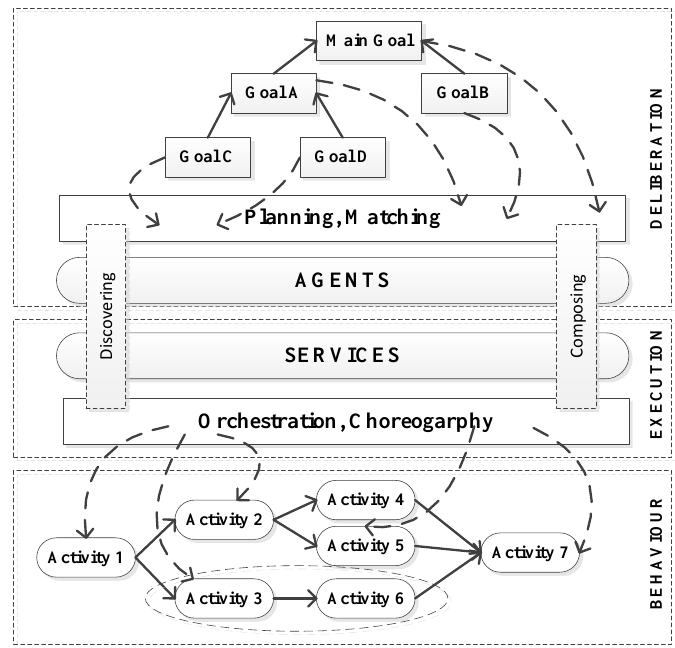
Figure 5. Conceptual view of the Pandora architecture, as described in [34].